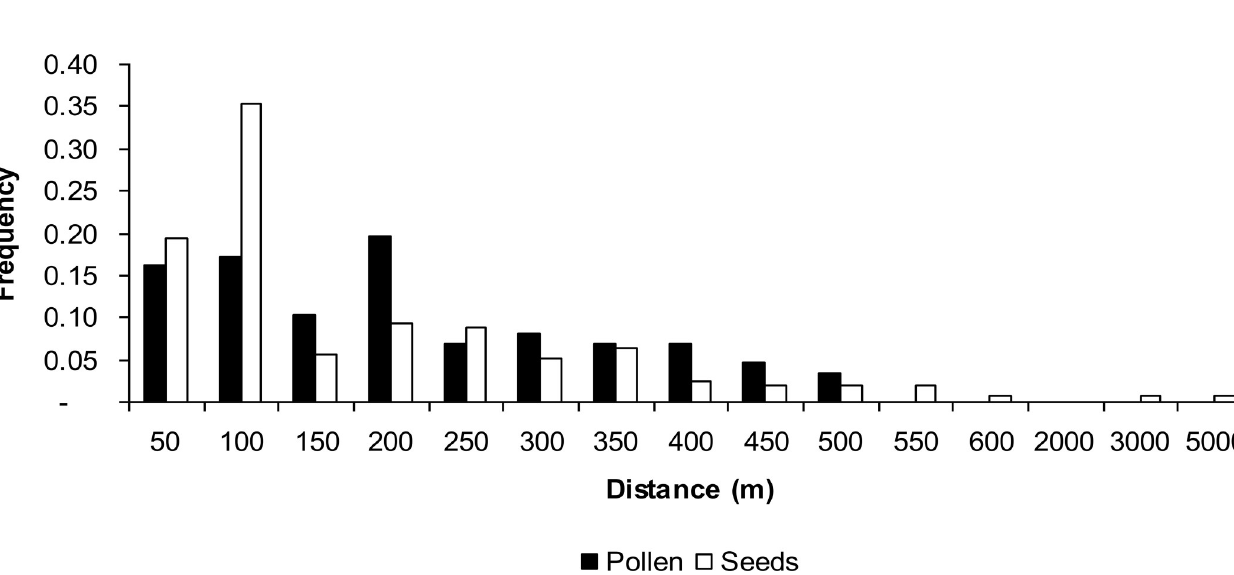
PLOS ONE | https://doi.org/10.1371/journal.pone.0255275 August 2, 2021 11 /